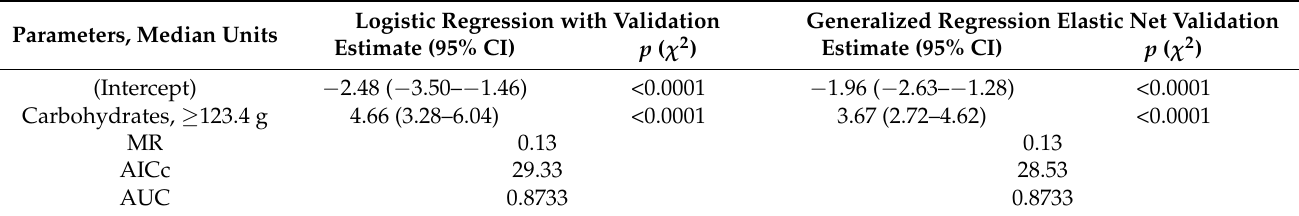
Table 4. Predictors of Glycemic Load ( ≤ 71.8).